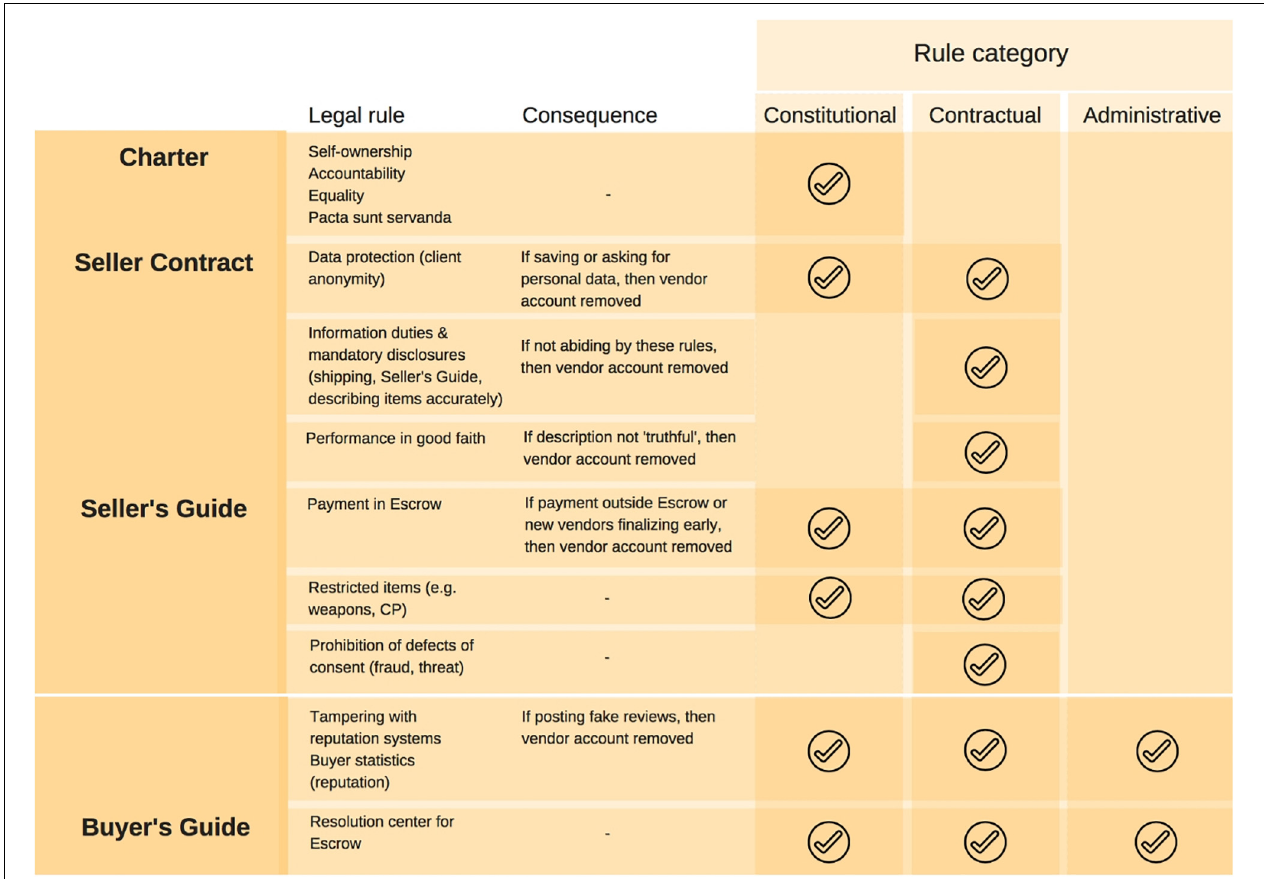
FIGURE 3 | Overview of the most prominent legal rules in terms of service.